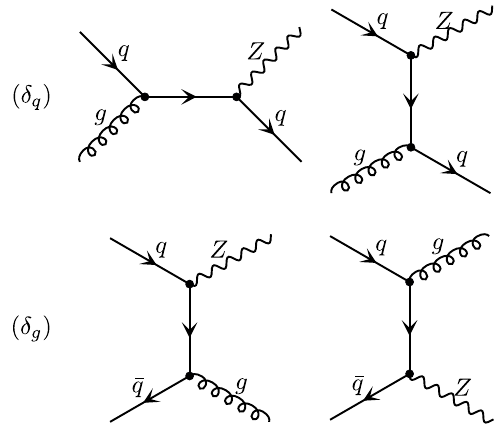
Figure 1 . Feynman diagrams contributing to the partonic Born process for Z +jet production at hadron